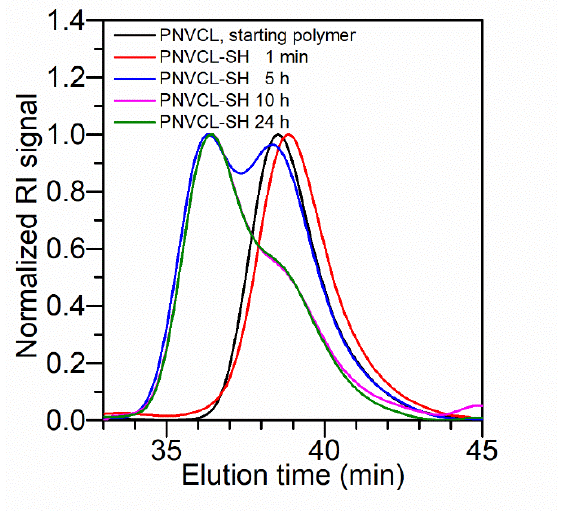
Figure 3. GPC traces in THF before and after aminolysis of linear PNVCL xanthate type and PNVCL-SH polymers. Starting polymer M n GPC = 14,400 g/mol and Ð = 1.22; 1 min M n GPC = 15,600 g/mol and Ð = 1.21; 5 h M n GPC = 20,130 g/mol and Ð = 1.27; 10 h M n GPC = 24,100 g/mol and Ð = 1.28; 24 h M n GPC = 31,000 g/mol and Ð = 1.35. The aminolysis was performed in dichloromethane using hexylamine (4 equiv per RAFT group) for 10 min.